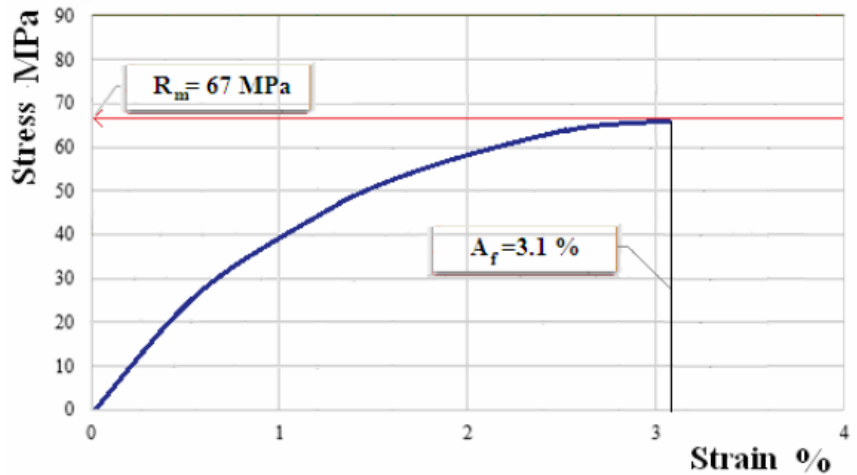
Figure 9. Characteristic curve for sample of composite material with matrix of hybrid resin of type 3, reinforced with fabric of first type.